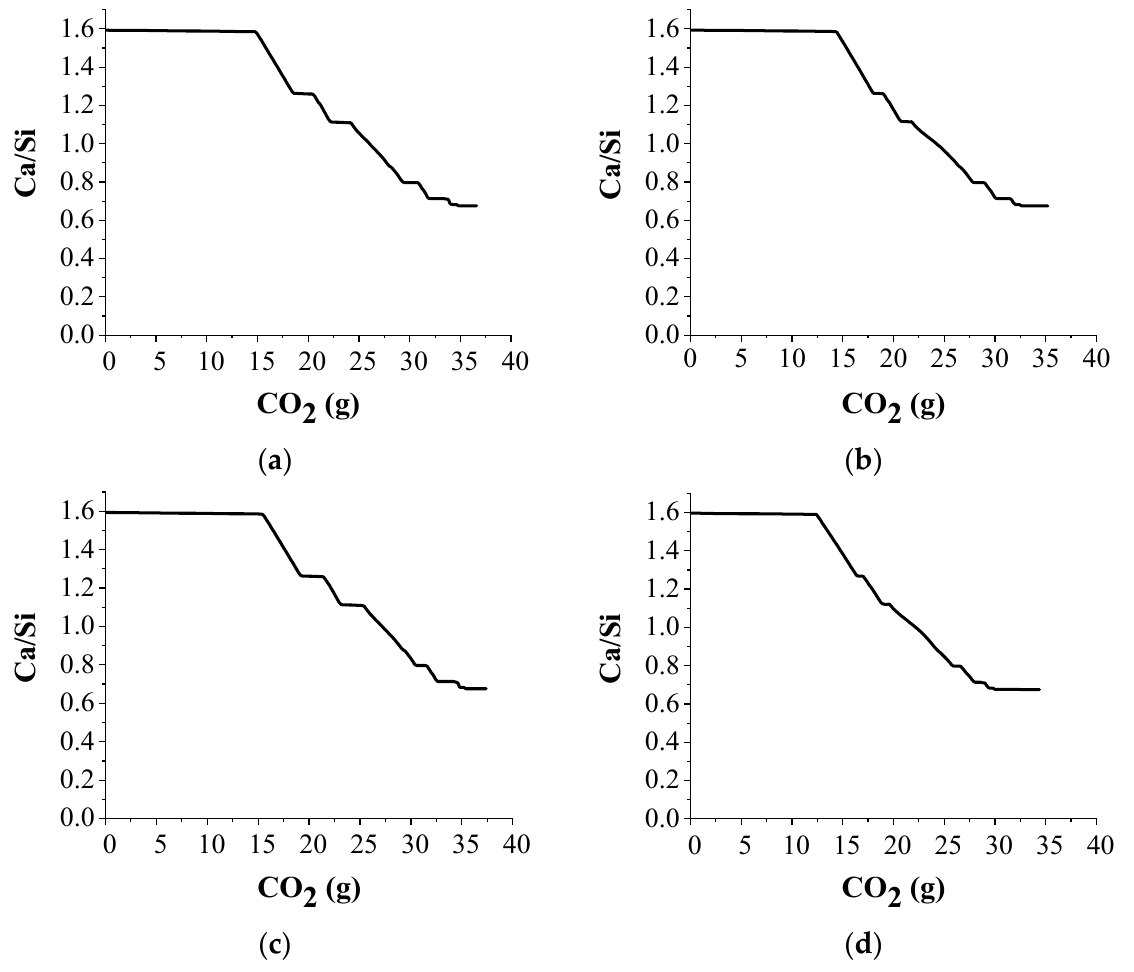
Figure 2. Change in the Ca/Si ratio of C-S-H during carbonation. ( a ) type I, ( b ) type II, ( c ) type III, ( d ) type IV.